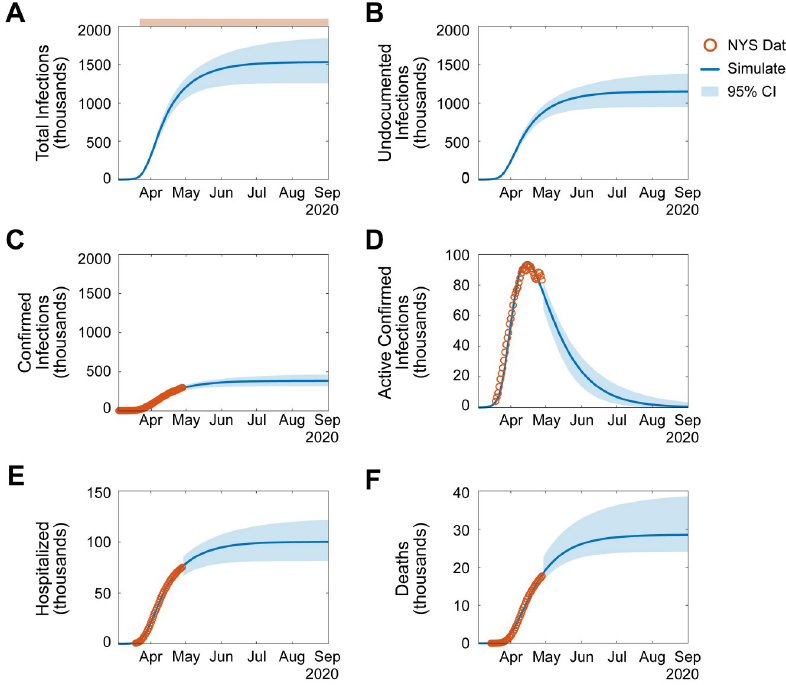
Fig 1. Simulating the effect of undocumented infections on SARS-CoV-2 transmission. ( A-F ). Simulation of SARS-CoV-2 transmission dynamics through September 1, 2020. NPIs signified as in (A) top: pink, NPIs initiated on March 22 nd , 2020. Orange circles, NYS SARS-CoV-2 data (see Methods). Blue line, simulated projection. Light blue box, 95% confidence interval. A . Cumulative total infections (undocumented infections + confirmed symptomatic infections). B. Cumulative undocumented infections. C. Cumulative confirmed symptomatic infections. D. Active confirmed infections. E. Cumulative hospitalizations. F. Cumulative deaths. See also, S2–S6 Figs, S3 Table.